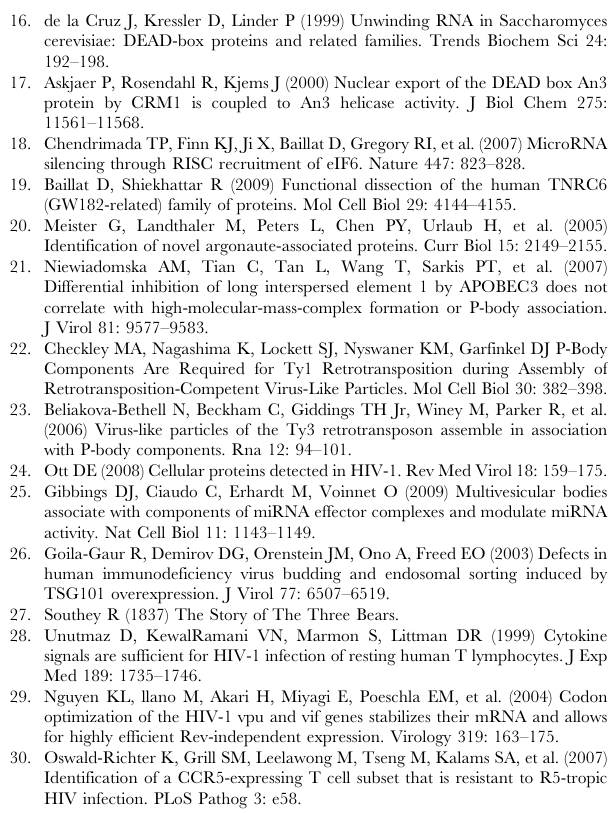
(pcDNA3) vector. Error bars represent standard error of the